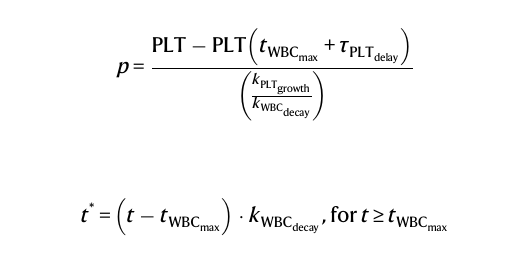
linear PLT increase during recovery despite signi fi cant differences in gender and age (bottom left of each panel), in fl ammatory stimulus, CBC frequency, and mag- nitudeofWBCandPLTcountchanges.SeeSupplementaryFigs.9 – 10foradditional representative WBC-PLT dynamics for patients whose raw WBC-PLT data had model fi tsnearthe25thand75thpercentilesofthecohortadjustedR 2 distributions. Thin black lines in panels ( a ), ( b ) are shown for 500 patients randomly selected from the adjusted R 2 distributions. Source data are provided as a Source data fi le. WBC: white blood cell count, PLT: platelet count, M: male, F: